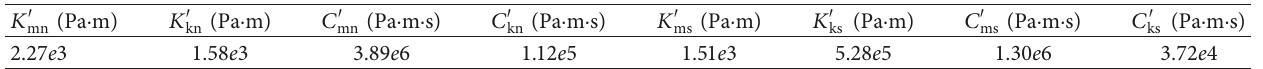
Table 8: Microparameters at contacts between asphalt mastic and aggregates.